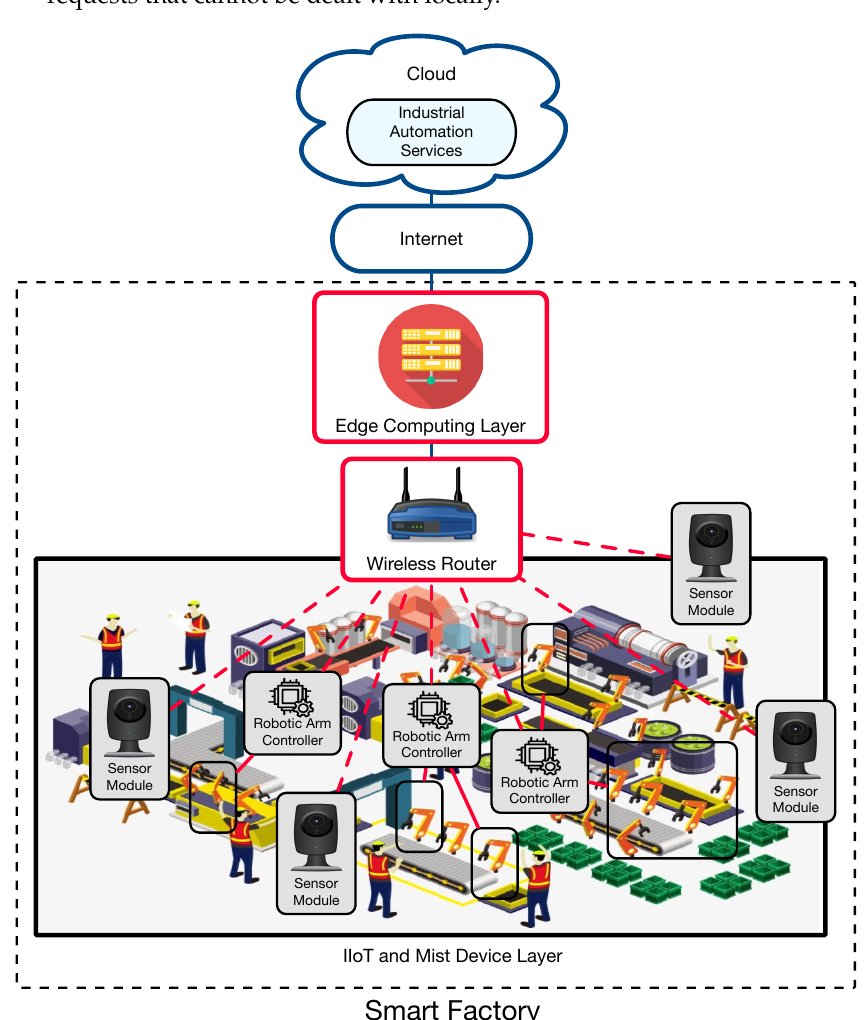
Figure 5. Communications architecture of the implemented